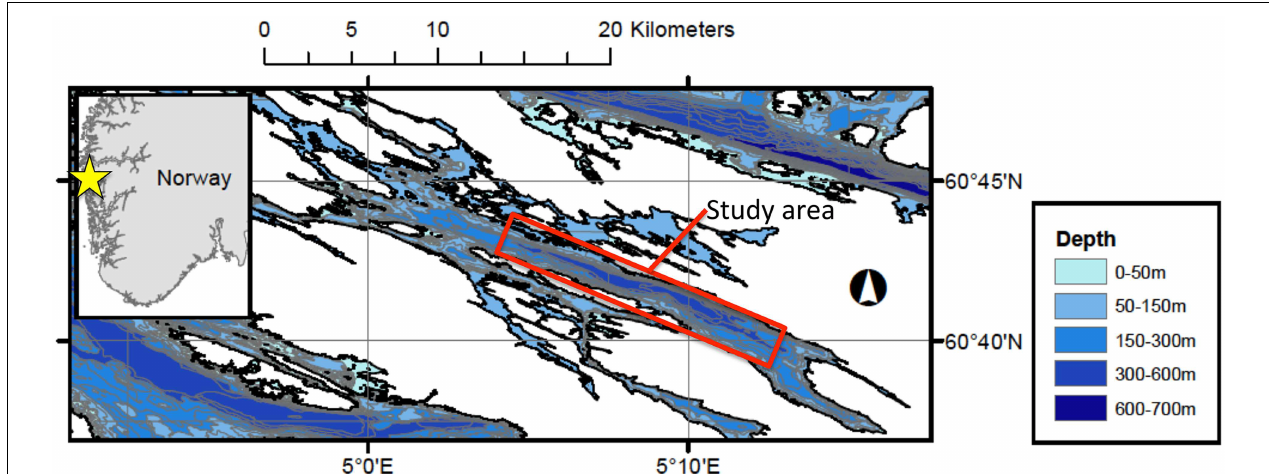
FIGURE 1 | Location of Lurefjorden, western Norway (yellow star), and approximate location of the study area in